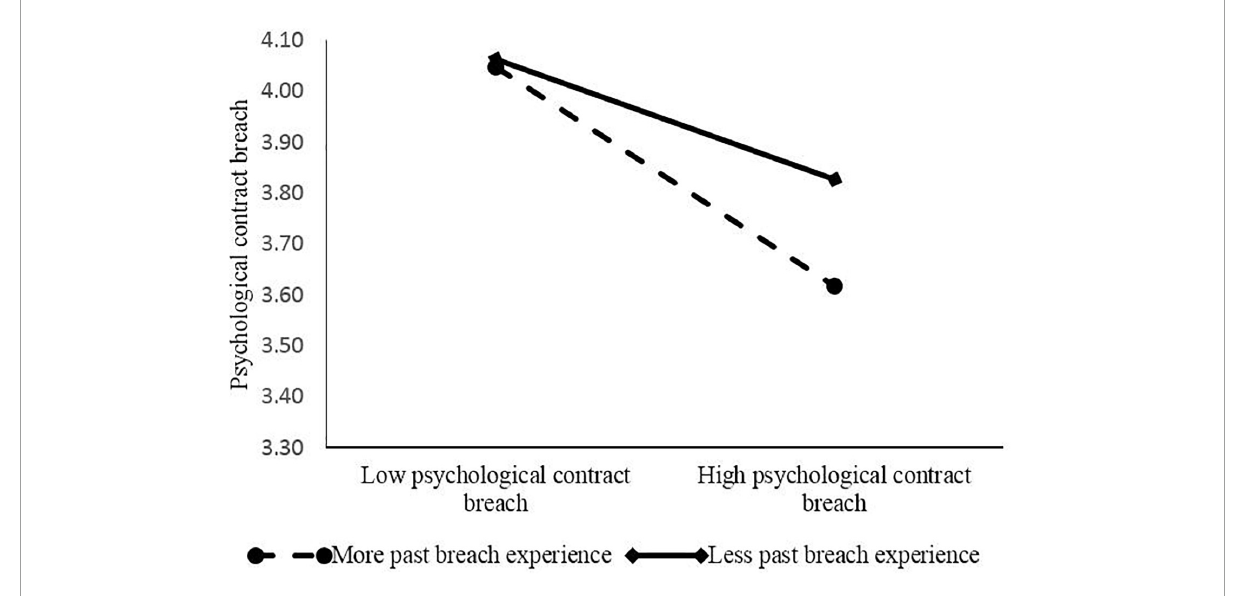
FIGURE2 Interaction between past breach experience and psychological contract breach.